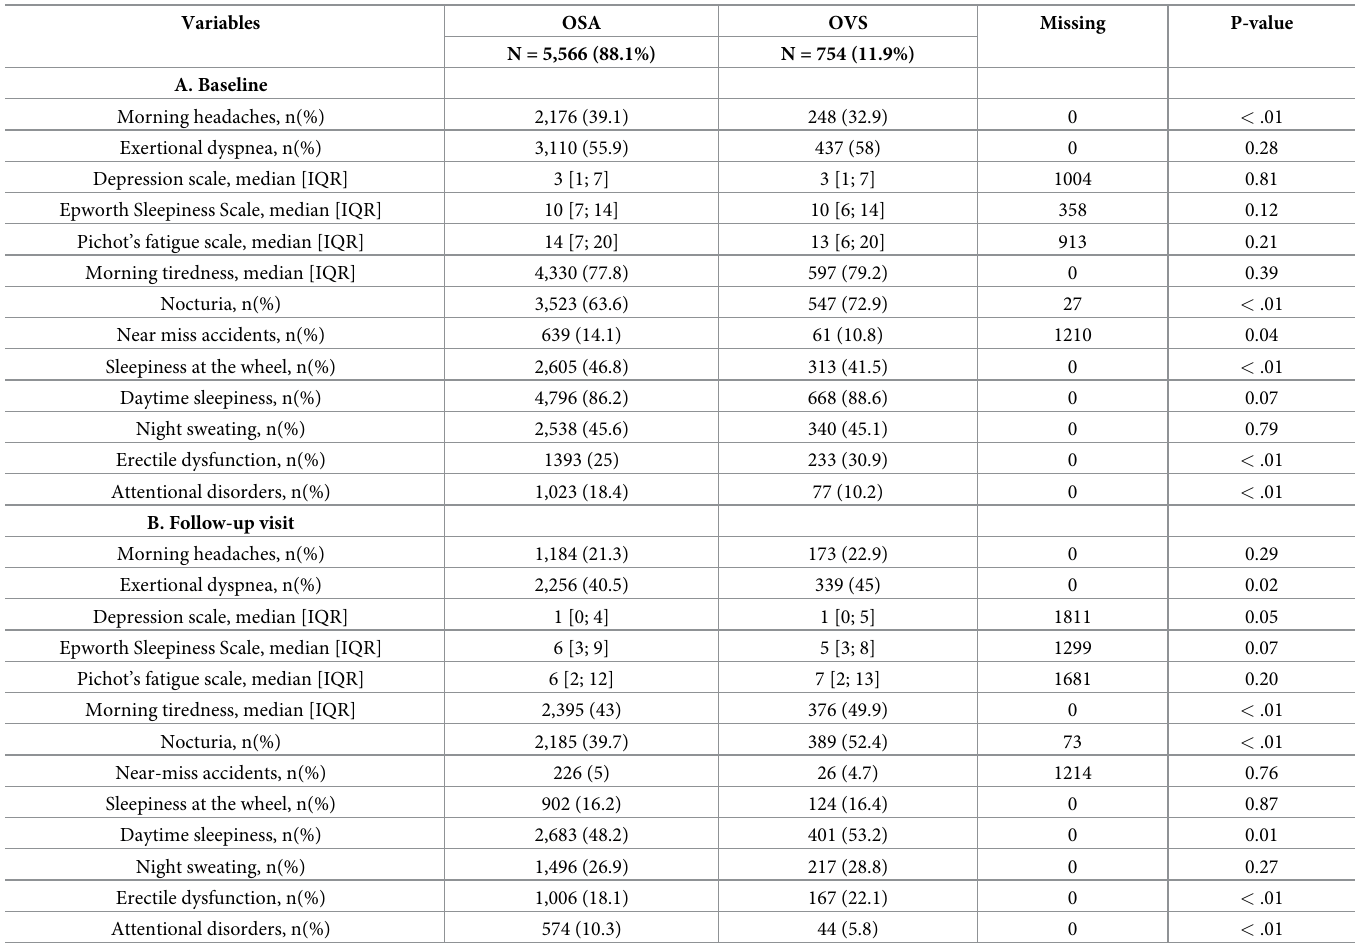
Table 2. Between-group difference in symptoms at baseline and follow-up